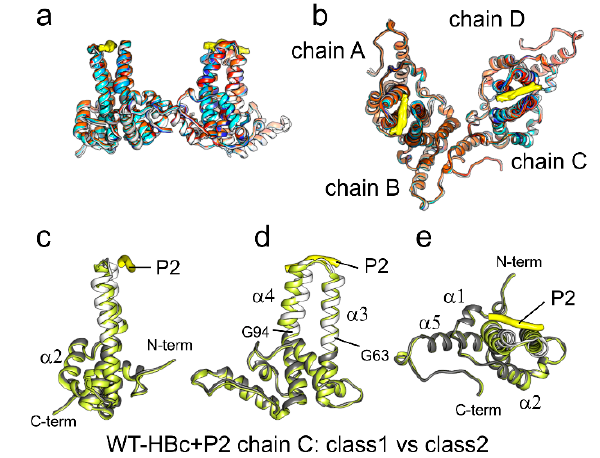
Figure 5. Models of HBc variants with bound peptide. ( a , b ) models of the asymmetric units with bound P1 or P2 are superposed. The peptides are shown in yellow, and the chains of the HBc variants are colored as follows: L60V-HBc + P2 in cyan, P5T-HBc+P1 in blue, P5T-HBc + P2 in dark blue, WT-HBc + P1 in white, WT-HBc + P2 in gray, F97L-HBc + P2 in red and F97L-HBc + P1 in orange. All models show essentially the same fold. The views in ( a , b ) are related by a 90° rotation around the horizontal axis; ( b ) shows a view from the outside of the capsids towards the center; ( c – e ) show three perpendicular views of the models of chain C (yellow and white/gray) modeled into the two most diverging classes of the asymmetric unit of WT-HBc + P2 (Figure S5). The two models were aligned by rigid-body alignment to compensate for their relative displacement. The two models diverge in the upper spike region hinged at G94 and G63. Most asymmetric units are similar to the yellow model, while the white/gray model represents only 15–20% of the asymmetric units in the analysis. Often binding of a ligand leads to more rigid structures than in the unbound